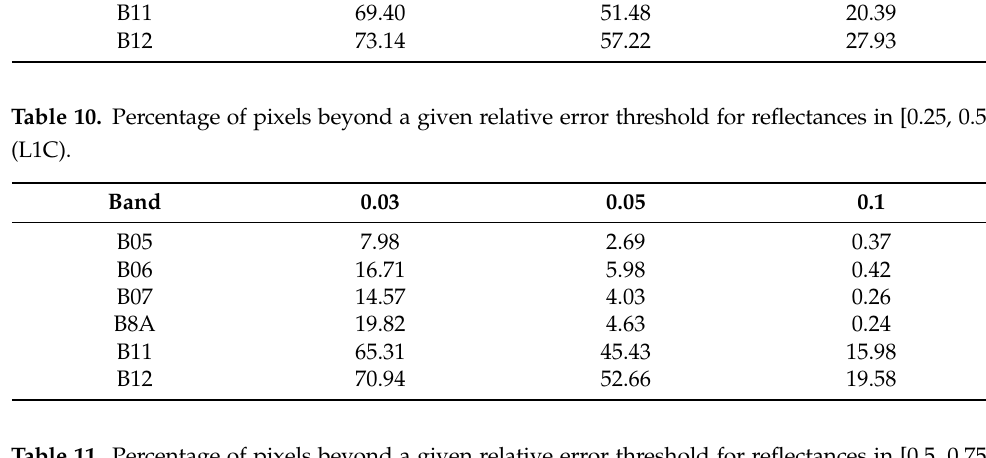
Table 11. Percentage of pixels beyond a given relative error threshold for reflectances in [0.5, 0.75] (L1C).